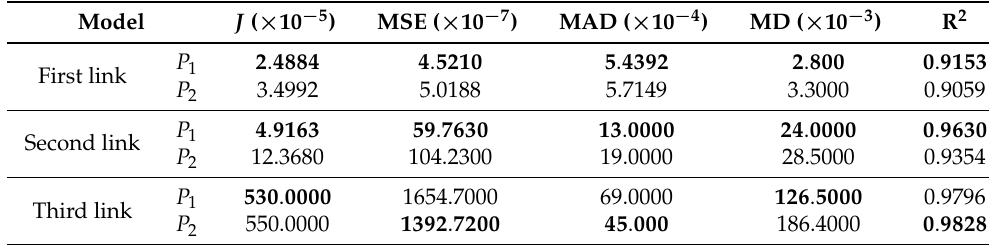
Table 3. Performance indices after fitting models P 1 ( s ) and P 2 ( s ) . Numbers in bold correspond to the best fit.